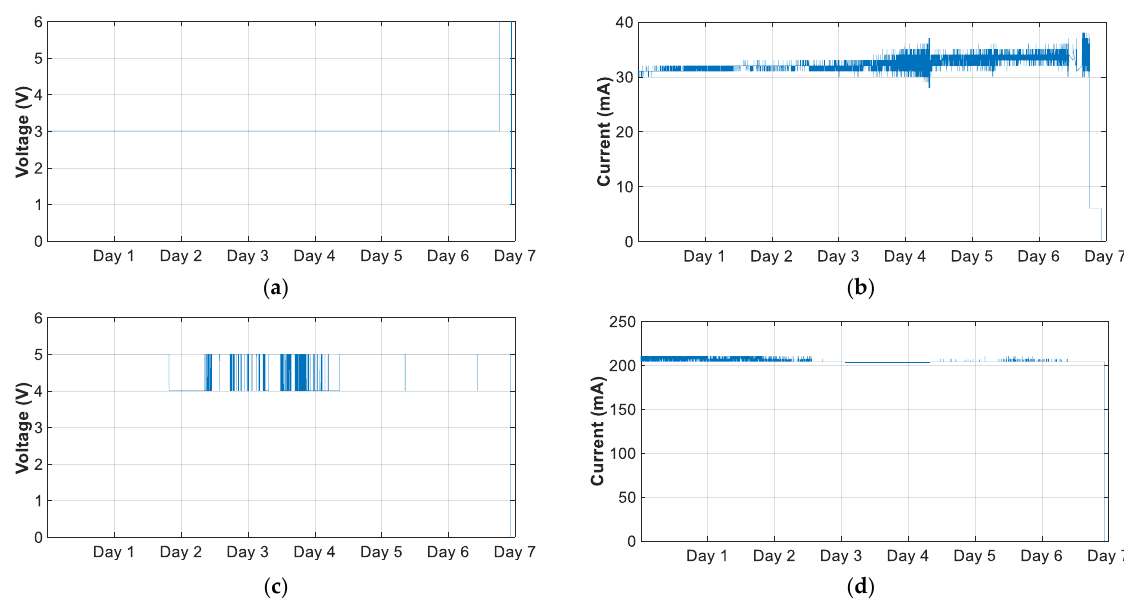
Figure 22. Discharge measurement: ( a ) battery voltage; ( b ) battery current; ( c ) LiPo out voltage; and ( d ) LiPo out current.